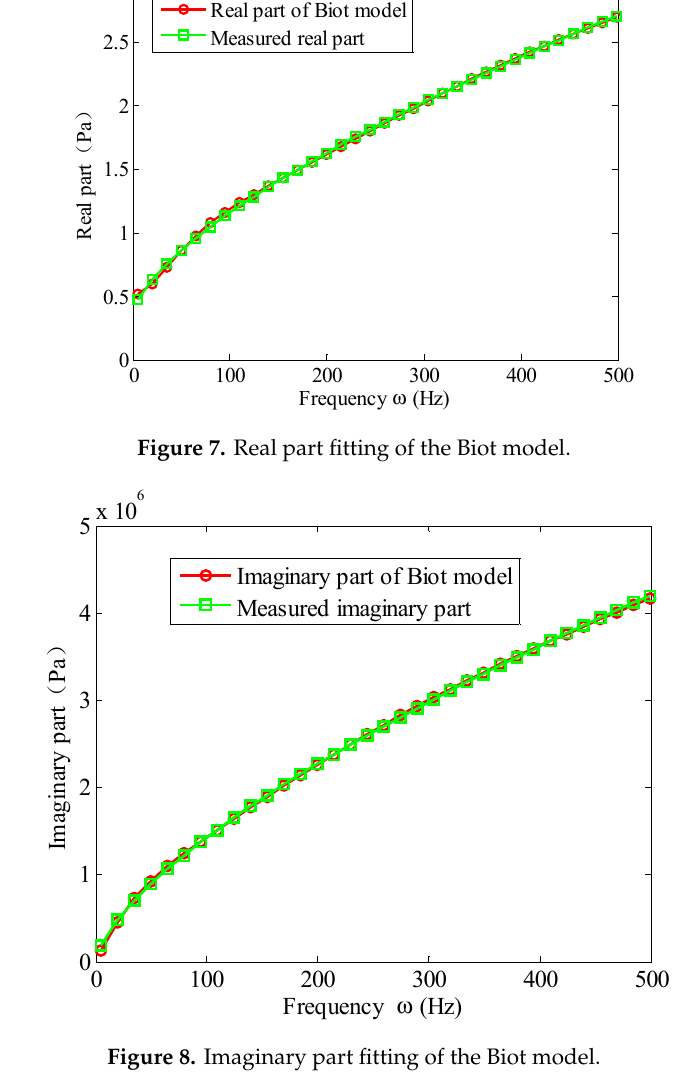
Figure 8. I maginary part fitting of the Biot model. Figure 8. Imaginary part fitting of the Biot